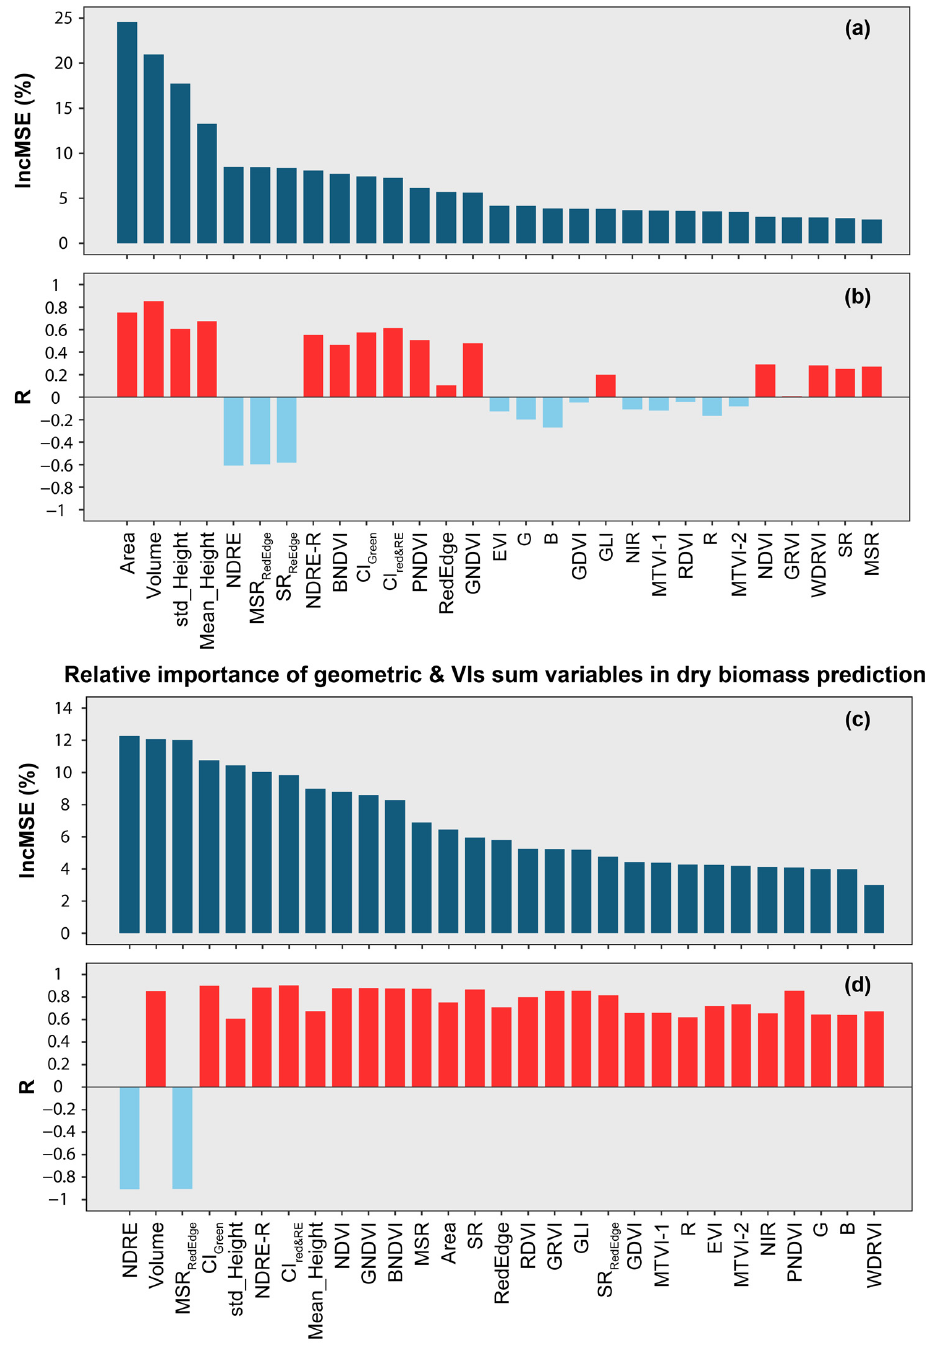
Figure 7. The relative importance of image-based features in the prediction of strawberry biomass: ( a ) importance of geometric parameters and VI mean variables for modeling dry biomass; ( b ) correlation coefficients of geometric parameters and VI mean variables with dry biomass; ( c ) importance of geometric parameters and VI sum variables for modeling dry biomass; ( d ) correlation coefficients of geometric parameters and VI sum variables with dry biomass. The dark green strip represents the mean decrease accuracy (%IncMSE) of various variables. The red and cyan strips represent the positive and negative correlations between the study variable with the dry biomass, respectively.